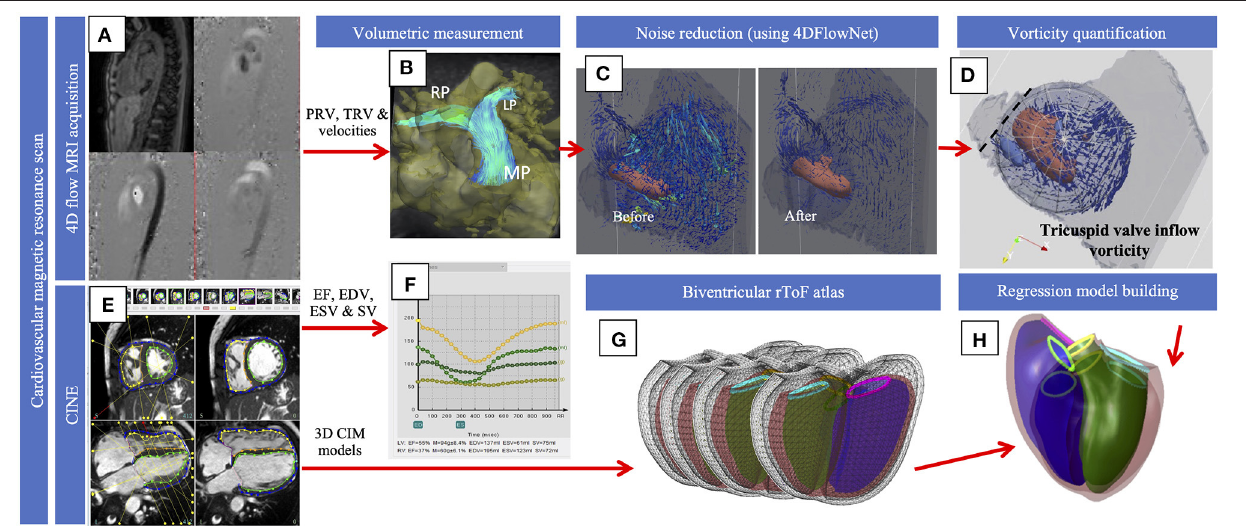
FIGURE 1 | Diagrammatic representation of the methodology. 4D flow (A) was used for volumetric quantification of flow in the pulmonary and across the tricuspid valve (B) and velocity data was processed with the 4D flow neural network (C) . Vorticity (D) was quantified and visualized with the vortex core and streamlines that demonstrate velocity within the spherical ROI was shown, and the dotted line represents the opening of the tricuspid valve. Cines (E) were used to extract EDV, ESV and SV (F) . Cines were also used to build the models for the current population that were projected onto the atlas (G) . Regression models (H) were used to compute shape variations associated with vorticity. The figure shows an overlapping of the diagrams of a normal biventricular model and the model generated to show the effect of